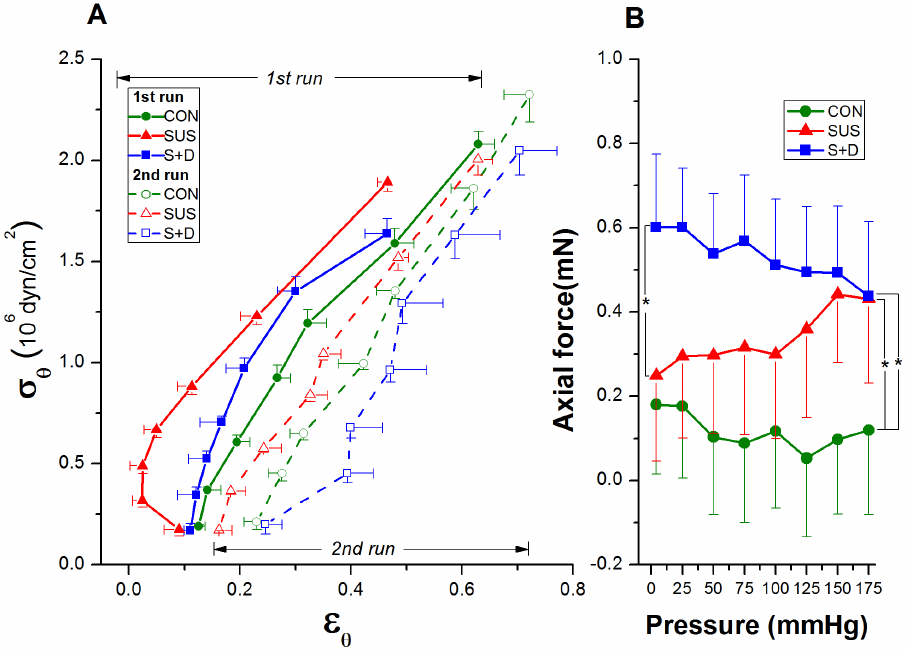
Fig. 2. (A) Active circumferential stress ( s h )-strain ( e h ) relationship of middle cerebral arteries isolated from CON, SUS, and S + D rats. Both s h and e h are calculated at the internal radius. The relationships calculated from the data of the first and second runs are depicted by curves drawn in thick lines with filled symbols and in dashed lines with open symbols, respectively. Values are means 6 SE. n =8 , 10 per group. (B) Axial force-pressure relationship of middle cerebral arteries isolated from CON, SUS, and S + D rats in active state within the intraluminal pressure range of 4 , 175 mmHg. The calculation was based on the data of the first run. Values are means 6 SE. n =13 per group. * P , 0.05 ( t -test).